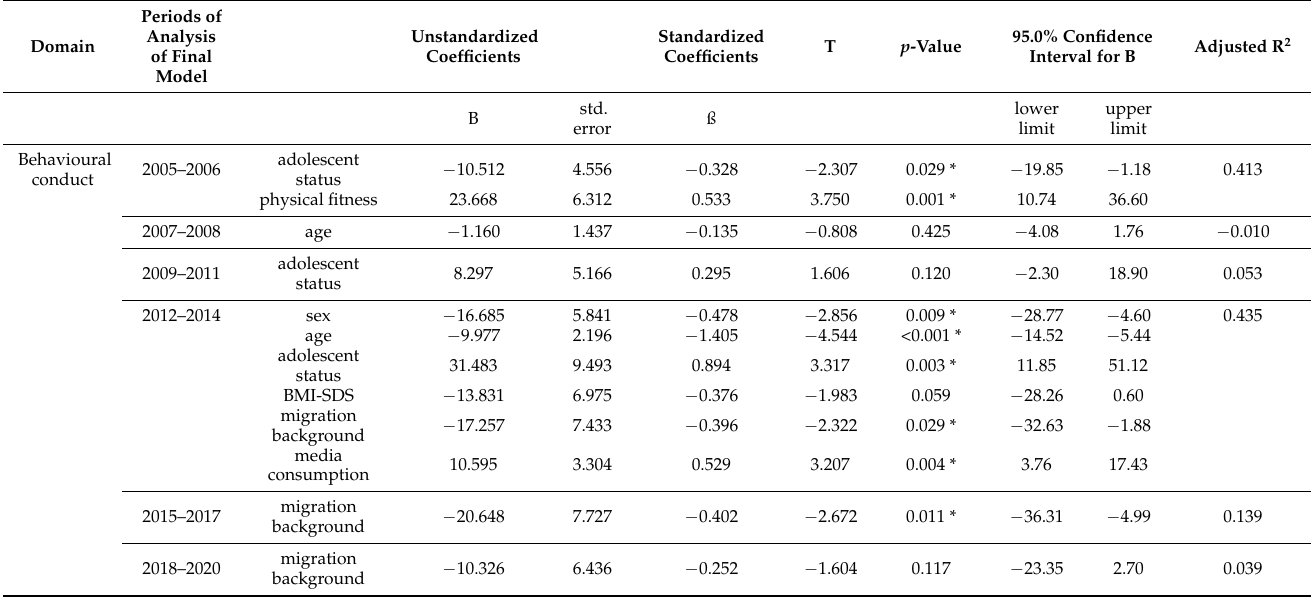
Table 8. Linear regression analysis (backward) of the behavioural conduct